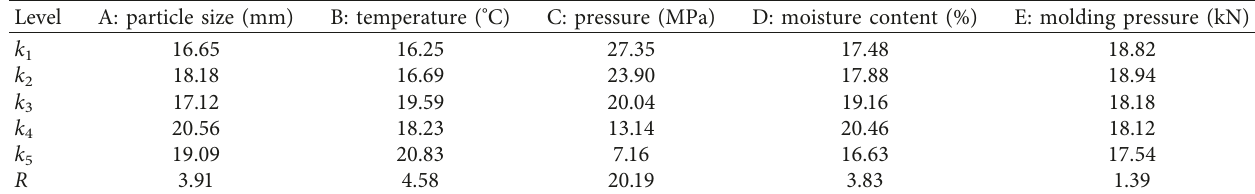
Table 4: Sensitivity analysis results of the gas desorption amount per unit mass in